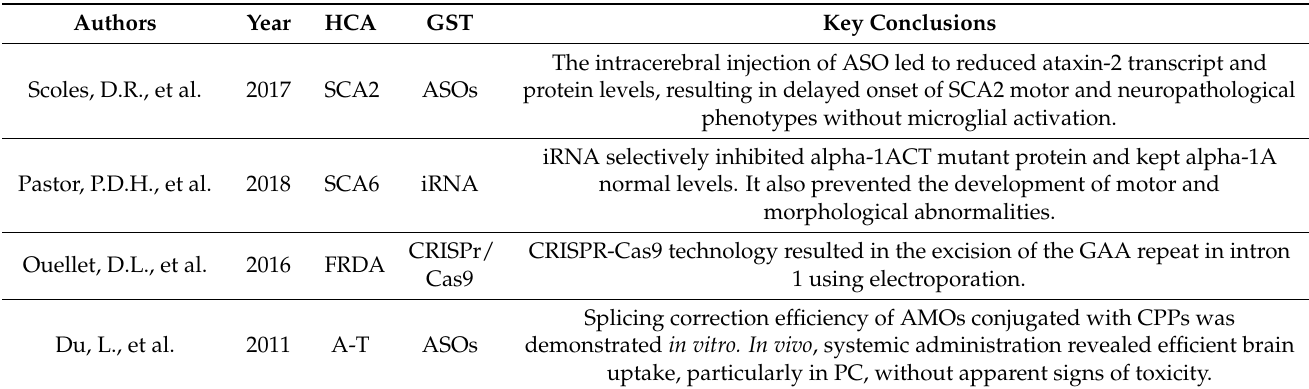
Table 4. Key conclusions from data extraction sheet—other SCAs